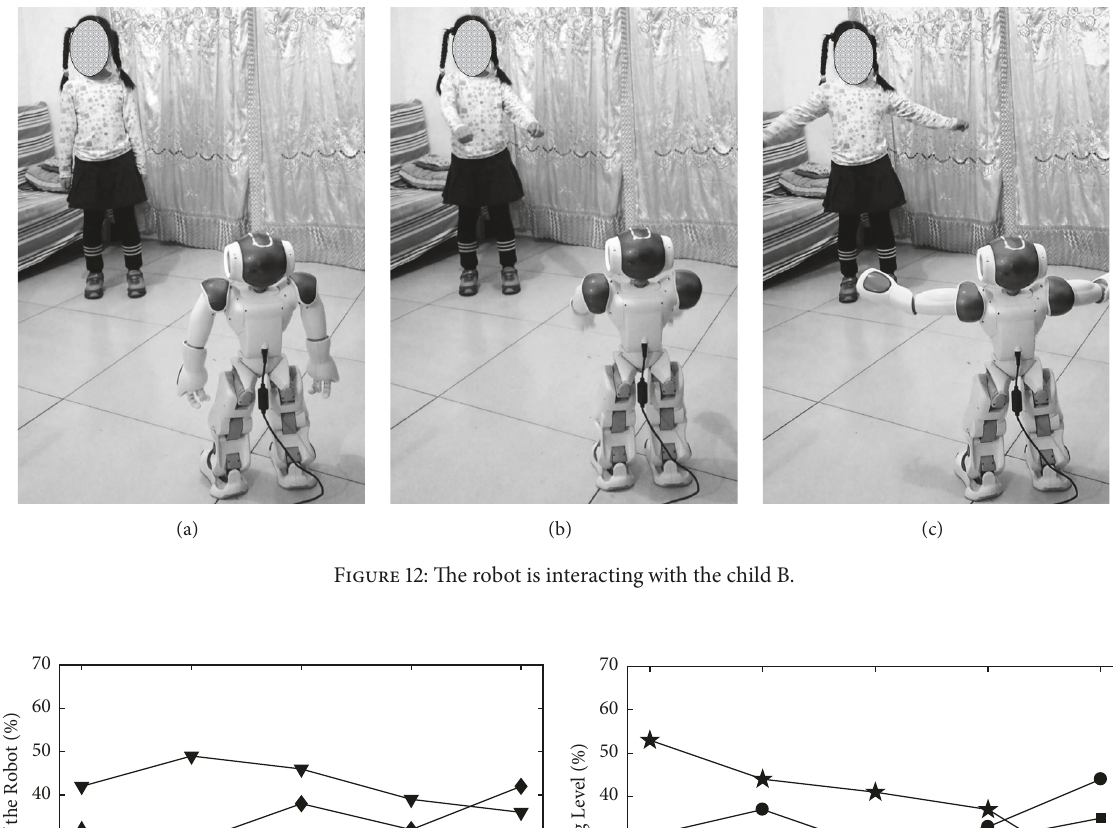
Figure 12: The robot is interacting with the child B.